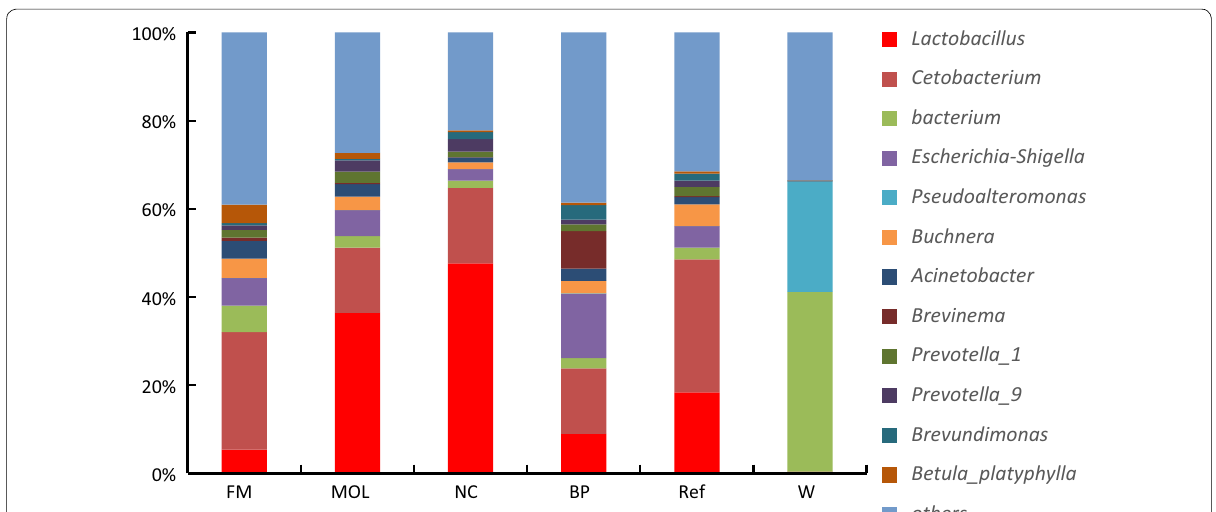
Fig. 3 The intestinal bacteria communities at genera level. The color‑coded bar plot showed the percentages of intestinal bacteria communities in W, Ref, BP, NC, MOL and FM groups at genera level. Others meant the relative abundance were less than